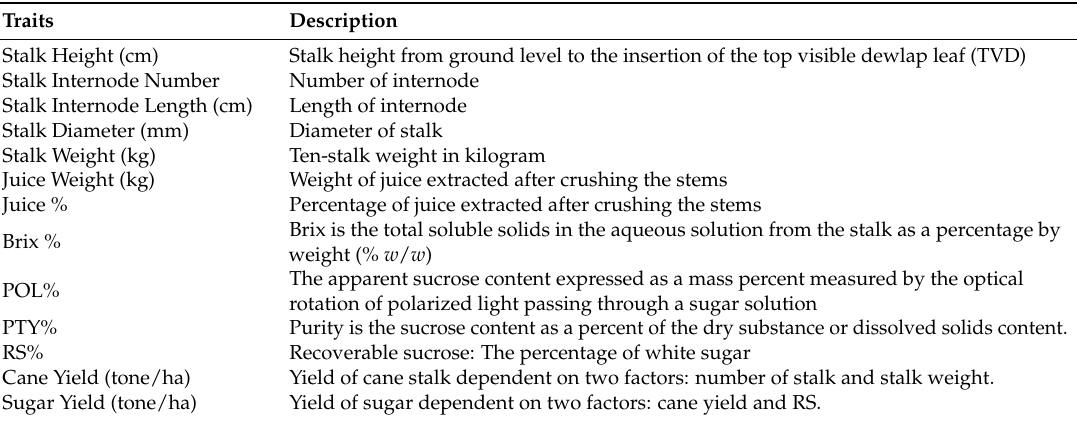
Table 1. Descriptors used for characterizing the sugarcane accessions of entire collection (253 accessions) in order to build a mini-core